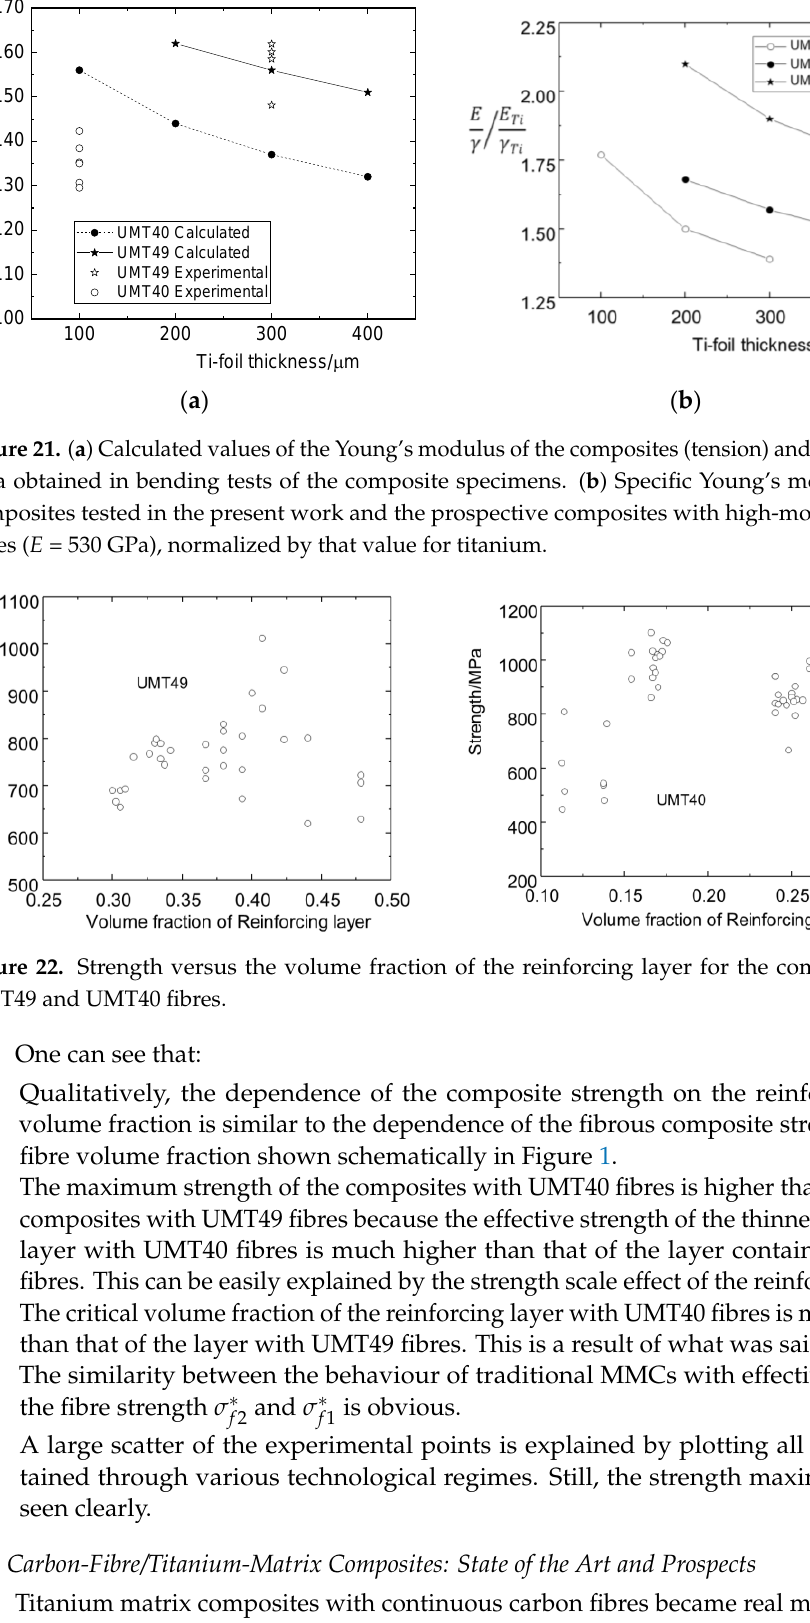
19 of 24 Figure 20. A typical load – displacement curve of the titanium main matrix specimen tested in 3-point bending at room temperature. A detailed description of the composite microstructures and the results of the mechanical testing of composite specimens can be found in [61]. Here, we just present generalized data on the mechanical behaviour of the composites produced through various fabrication regimes. Elastic characteristics of the composites are obviously given by a linear combination of the elastic moduli of the components. Hence, they can easily be calculated, provided that the volume fractions of the components are known. An analysis of the composite microstructures gives the volume fractions of the main titanium matrix and the reinforcing layer composed of carbon fibres, titanium carbide, and intermediate matrix. The experimental data obtained through 3-points bending and the results of the c alculation of the Young’s modulus E in ten-